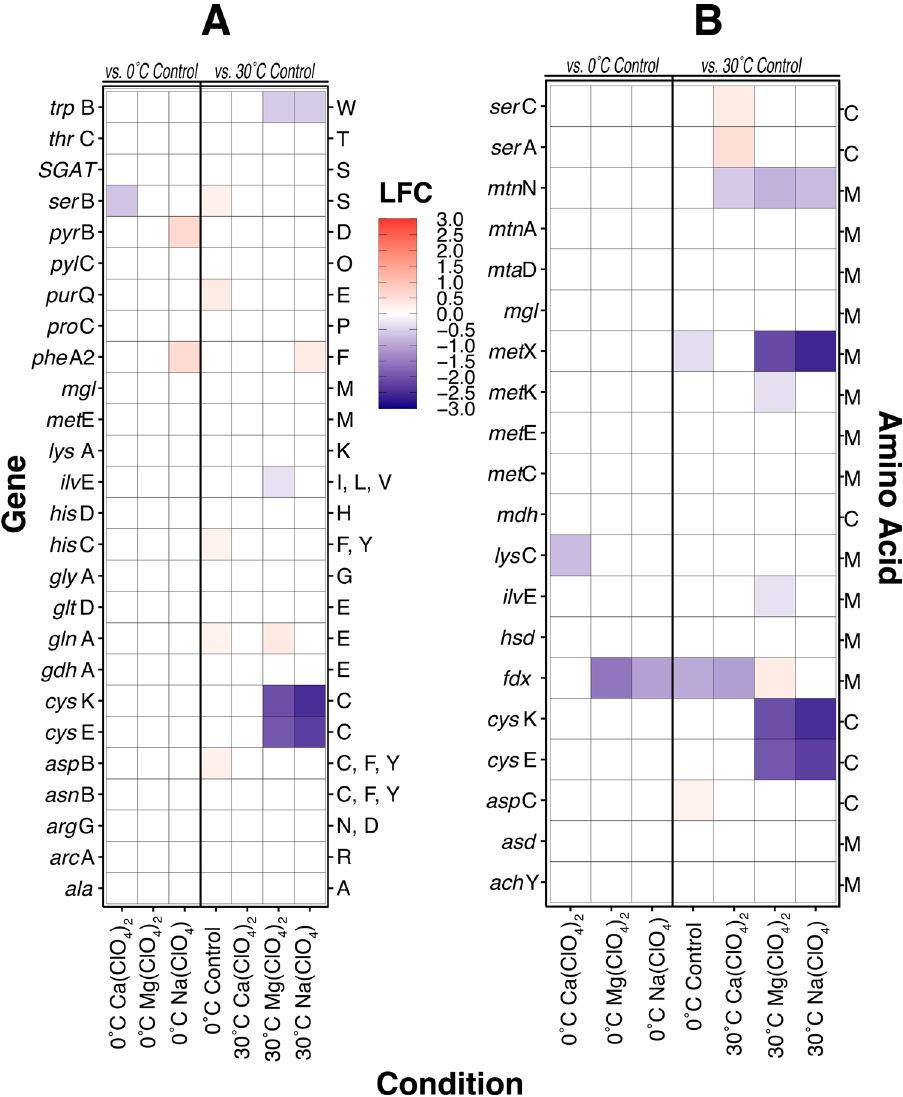
Figure 5. Differential expression (Log 2 -fold change, LFC) of genes involved in ( a ) amino acid synthesis and ( b ) recycling of the sulfur-containing amino acids methionine and cysteine in M. barkeri MS. Perchlorate-amended 30 °C and 0 °C perchlorate-free control cultures are relative to 30 °C perchlorate-free control. 0 °C perchlorate- amended cultures are relative to 0 °C perchlorate-free control. Full names of gene and amino acid abbreviations are respectively found in Tables S16 and